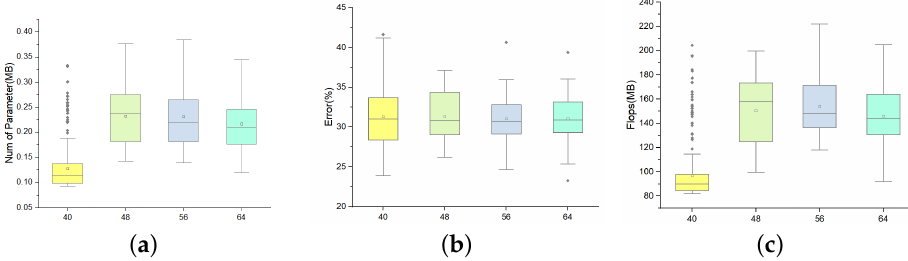
Figure 7. The population searched on UniMiB-SHAR based on the tri-objectives search objective. ( a ) Number of Parametres. ( b ) Error. ( c ) FLOPs.